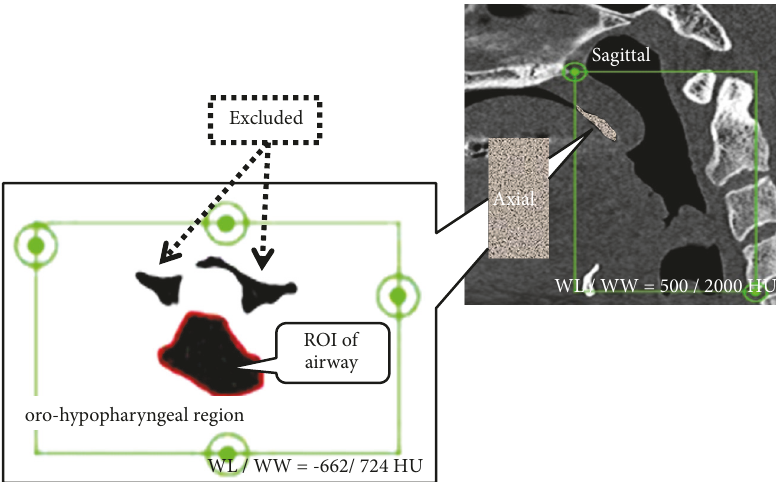
Figure 5: The region of interest (ROI) for calculating the airway volume. Abbreviations: WL/WW, window level/window width.